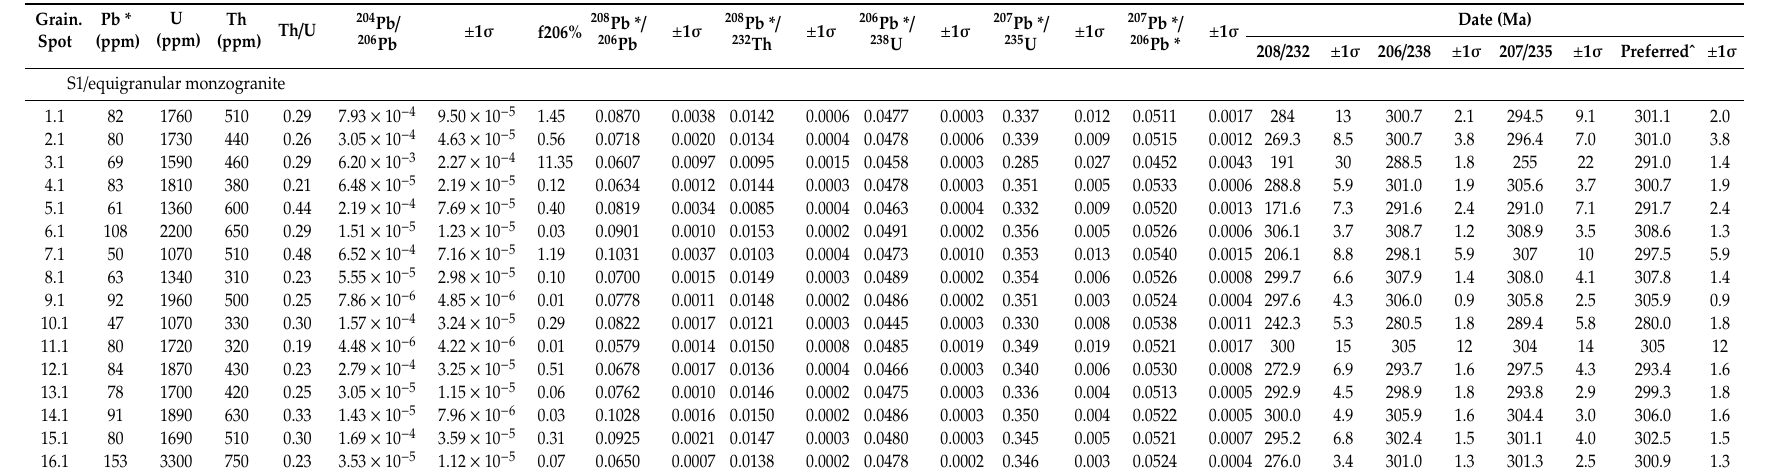
Table A4. cont. SHRIMP data of zircons from equigranular monzogranites and rhyolite porphyry from the Karkonosze Pluton and its eastern metamorphic cover. Grain.